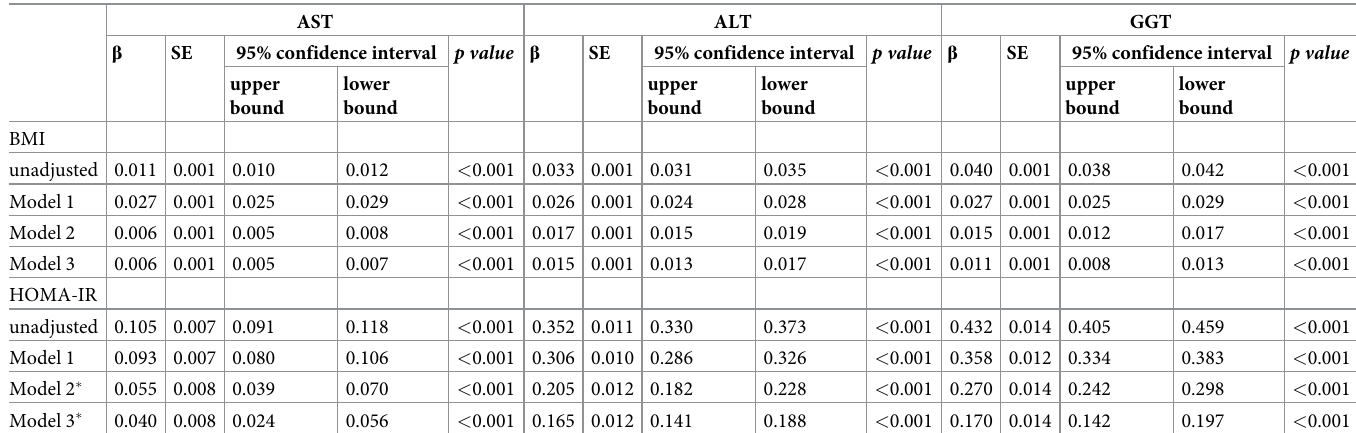
Table 3. Multivariate linear regression analysis for the risk of elevated liver